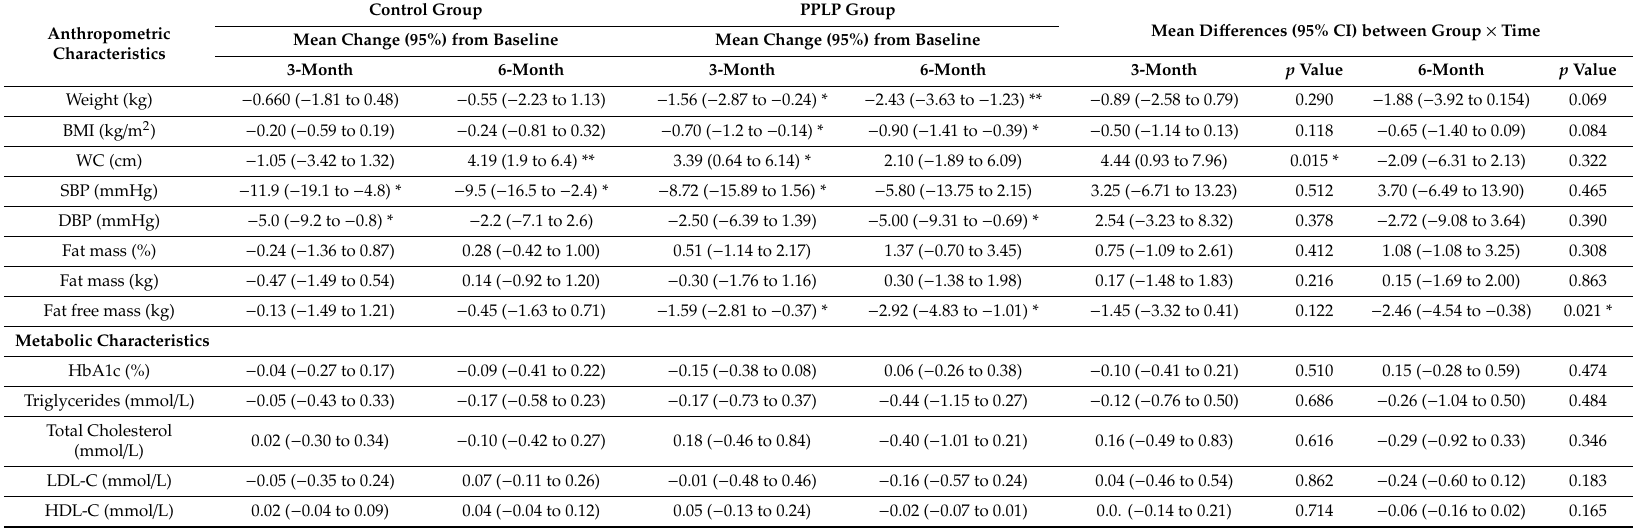
Table 3. Anthropometric and metabolic changes from baseline to 3- and 6-month follow ups with di ff erences within and between groups over time. Anthropometric Characteristics